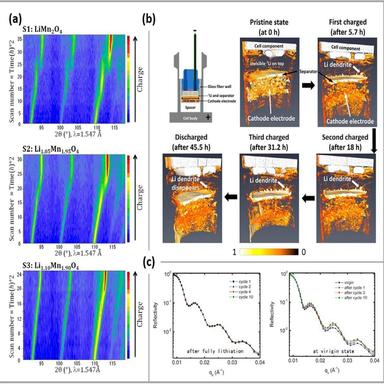
(a) Operando ND patterns of Li1+xMn2–xO4 cathodes of diverse Li/Mn ratio in Li-ion batteries (Reproduced with permission from ref. Copyright 2014 American Chemical Society); (b) the structure of testing Li/LiPF6/LiMn2O4 cell (1st image) and 3D distribution of lithium in the battery at different electrochemical states (Reproduced with permission from ref. Copyright 2019 American Chemical Society); (c) in-situ NR patterns of silicon thin film anode for lithium storage for different